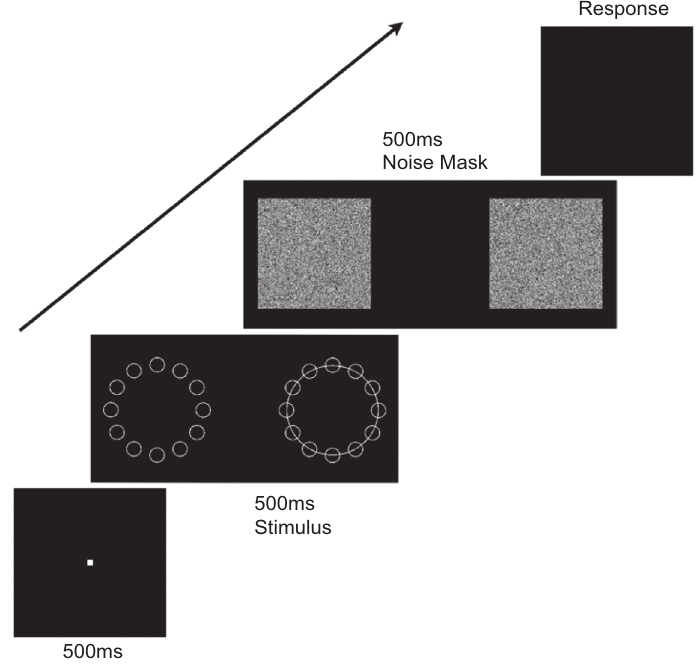
Figure 3. Schematic diagram of a trial in experiment 1. A fixation point appeared for 500ms followed by the presentation of the reference and test array for 500ms at which point the stimuli were removed from the screen and replaced by a noise mask for another 500ms to prevent the formation of afterimages. The screen then remained blank until participants indicated which array appeared larger via a key press.